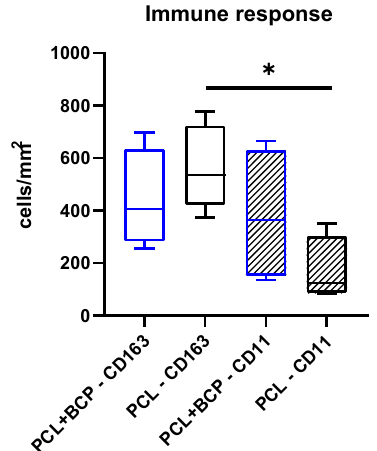
Figure 6. Histomorphometrical results of the measurements of the macrophage subtypes at day 15 post implantationem within the subcutaneous connective tissue (* = intraindividual differences, * p < 0.05).